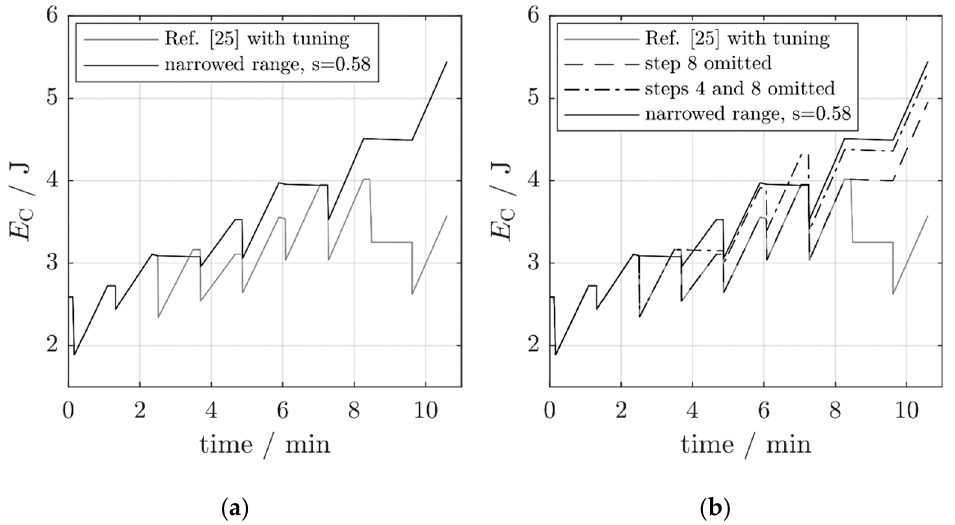
Figure 12. The capacitor energy for various operating modes of the self-adaptive harvester from Ref. [25]. ( a ) Operation with a narrowed adjustment bandwidth (s = 0.58). ( b ) Comparison with the results from Figure 11.